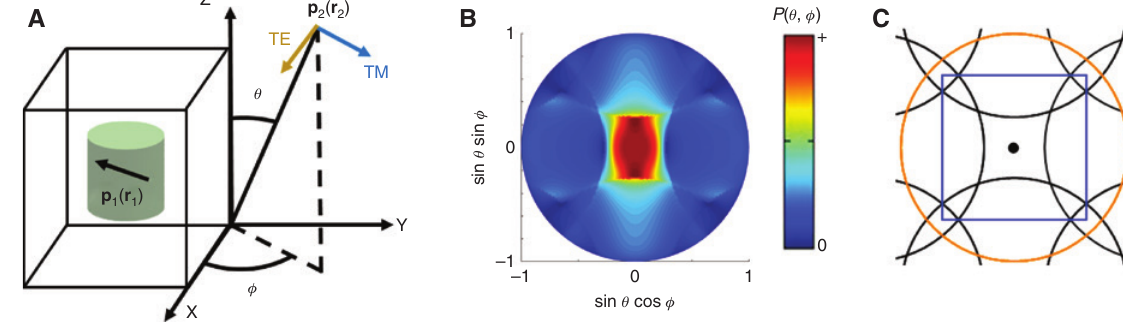
Figure 10: Calculations based on the reciprocity principle. (A) Sketch of the unit cell with two sources p (C) Corresponding repeated zone scheme